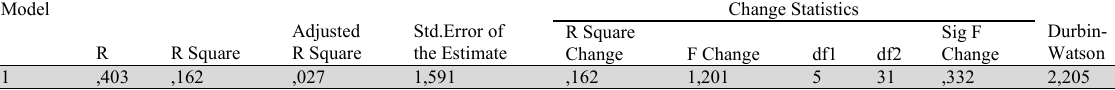
Model Summary – Rational Predictors Model